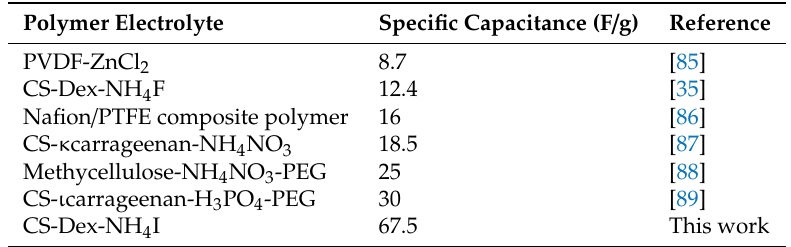
Figure 11. Specific capacitance of the assembled EDLC for 100 cycles.